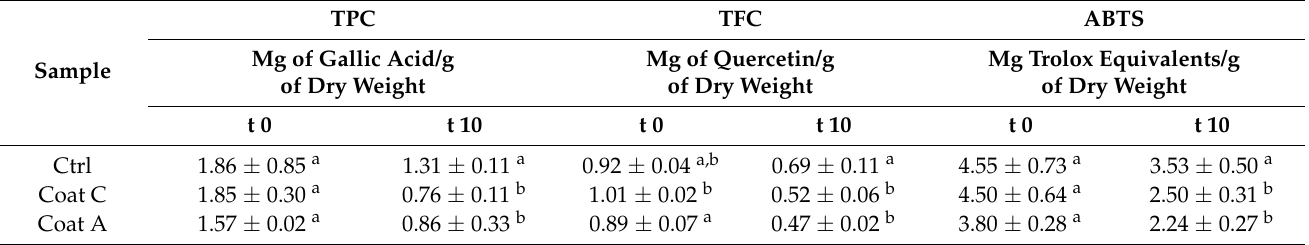
Table 4. Polyphenol content (TPC), flavonoid content (TFC) and antioxidant activity (ABTS) of coated and uncoated prickly pears during storage at 4 ◦ C.